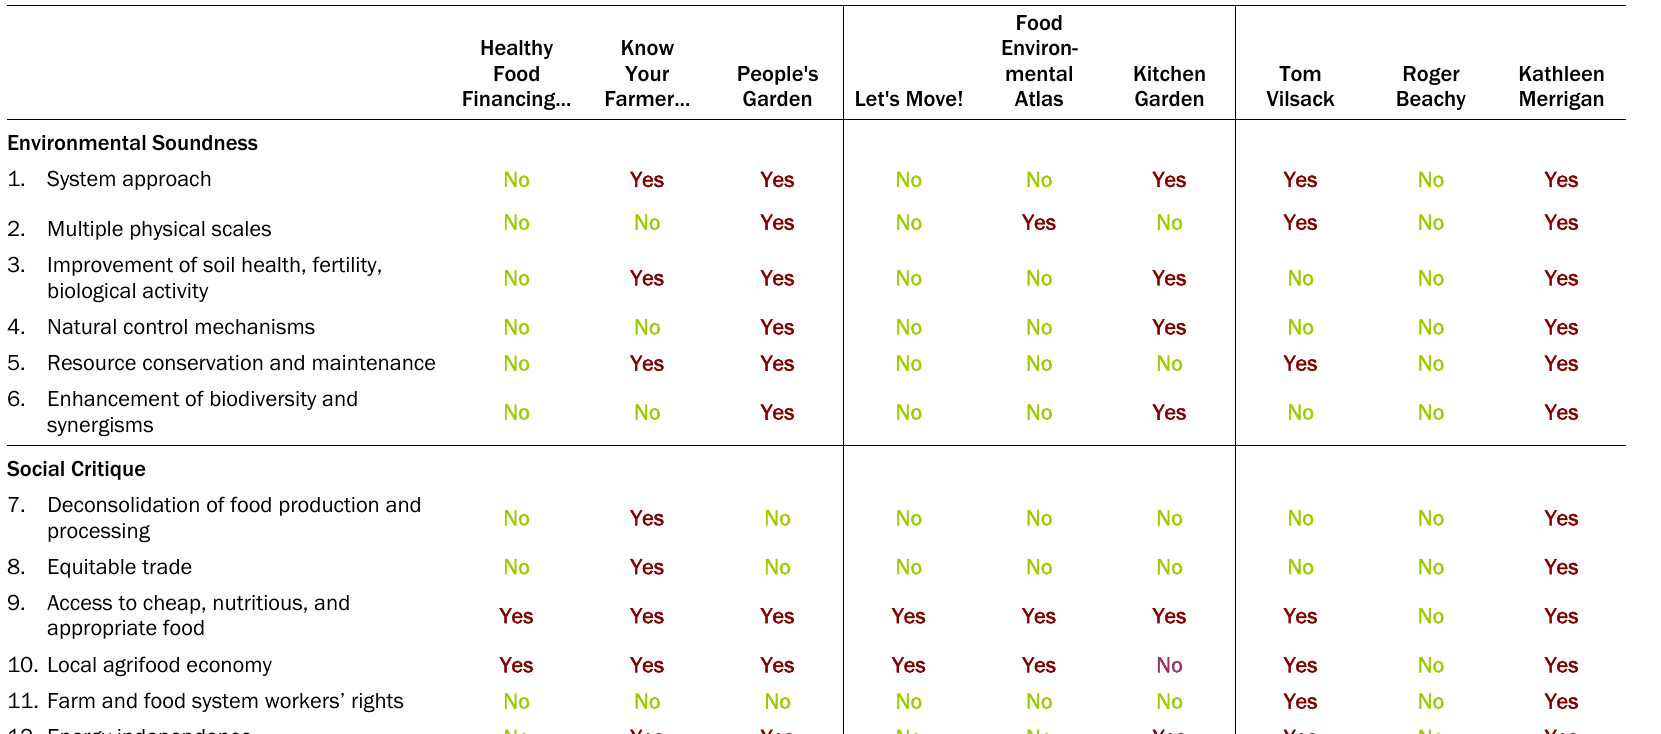
Table 2. Results for All